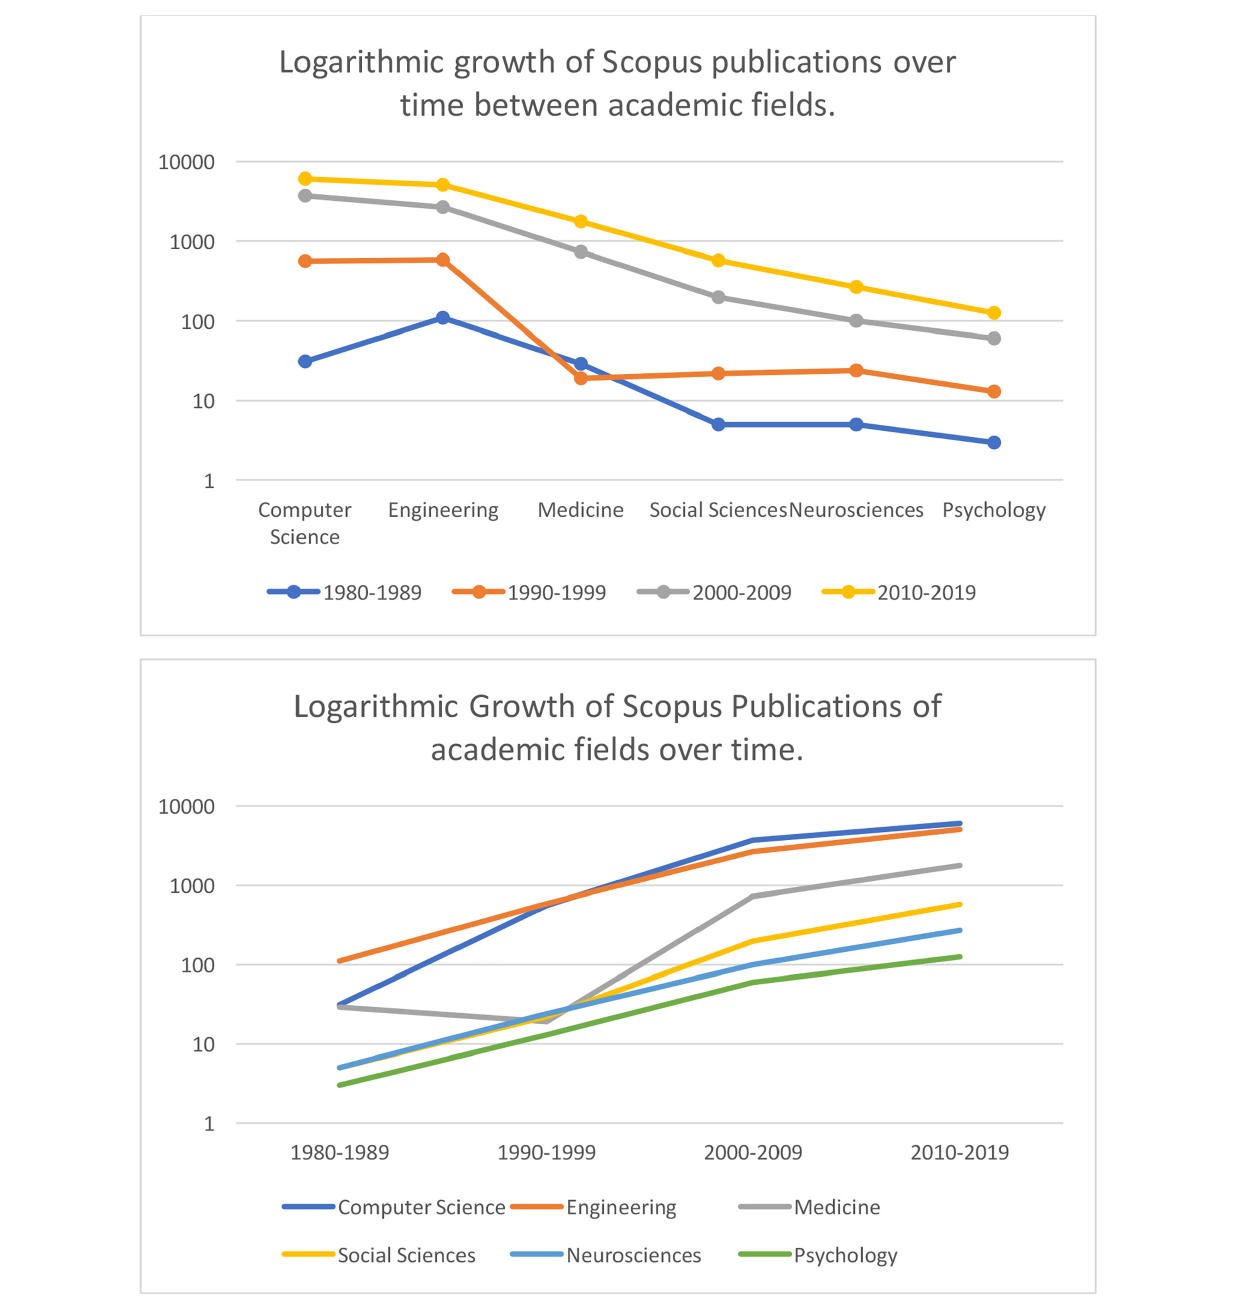
FIGURE 4 | Logarithmic Scale of Scopus publication growth from 1980 to 2019 across fields containing key search terms. Search terms: (“allintitle, abstract or keywords”: “3-D face” OR “3D face” OR “three-dimensional face” OR “three-dimensional face” OR